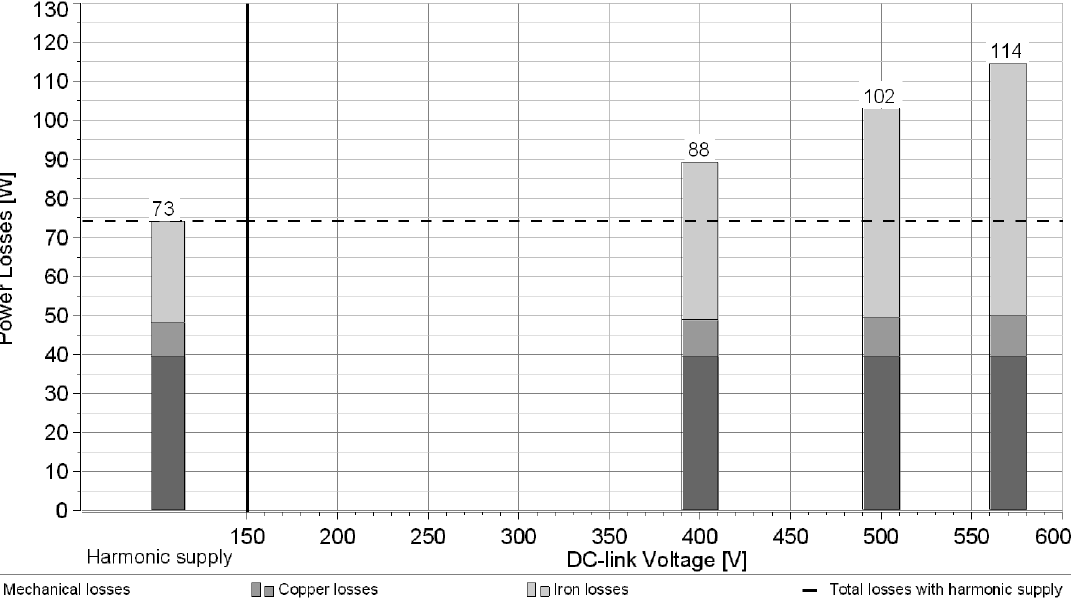
Figure 10. Motor speed 1000 rpm and no-load condition: loss distribution in the case of a sinusoidal supply (left) compared to a loss distribution of the PTC-controlled IM (right) with the reference stator flux 1 Wb and different values of DC-link voltage.